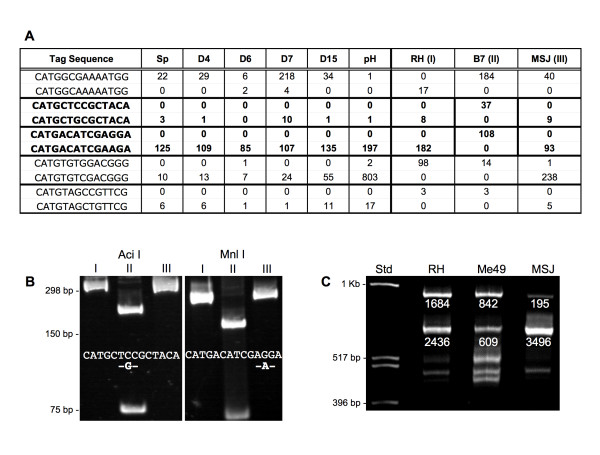
Single nucleotide polymorphisms and differential polyA+-choices are reflected in SAGE tag datasets. [A] Screening for reciprocal frequency patterns of nearest neighbor SAGE tags identifies potential strain-specific polymorphisms within the SAGE library datasets. Out of more than 400 tags containing SNPs, a selected set of five SNP-containing SAGE tags that represent all known biallelic patterns are shown [31] (I, III versus II; I, II versus III; II, III versus I). SAGE tag frequencies from all nine libraries are listed; VEG post-sporozoite SAGE libraries; Sp = sporozoite, D4 = Day-4 post-sporozoite infection, D6 = Day-6, D7 = Day-7, D15 = Day-15, pH = alkaline shifted parasites. [B] RFLP analysis was performed to verify strain-specific polymorphisms in two selected SAGE tags. Primers were designed from sequence flanking each SAGE-tag position within Toxoplasma genomic sequence. PCR fragments were amplified from genomic DNA from each of the three genotypic strains, purified, and digested with the appropriate restriction enzyme. Molecular mass standards are displayed. The sequence for Type II SAGE tag CATGCTCCGCTACA is found on chromosome V-1,674,592 and contains a mutation in the Aci I binding site. The Type II SAGE tag CATGACATCGAGGA is located on chromosome X-2,748,371 and within the coding region for the Toxoplasma homolog of SUL1 (AAF76883.1). A single nucleotide change in Type I and III SAGE tag occurs within the binding site for restriction endonuclease Mnl I. Note that in each case shown the sequence variation is biallelic; I, III versus II. [C] SAGE tag clusters indicate strain-specific differences in polyA+-addition. A 3'RACE reaction was performed on Type I (RH), Type II (ME49B7) and III strain (VEG) total RNA using a GRA7-specific primer in conjunction with a modified oligo-d(T) primer. The distance of the Nla-III site (anchor site for each SAGE tag) from the GRA7-specific primer was correlated to the 3'-RACE products and the 3'-RACE products were verified by cloning and sequencing. The corresponding tag frequencies for the top two 3'RACE products are indicated below the band in each strain. Four tags with similar frequency were obtained from the Type II library that correlate with Type II 3'-RACE products; 3'-RACE 951 bp product = tag with 842 frequency, 600 bp = 609 tags, 520 bp = 136 tags, 409 bp = 401 tags. The 951 bp and 600 bp 3'-RACE products were dominant in RH and VEG strains.